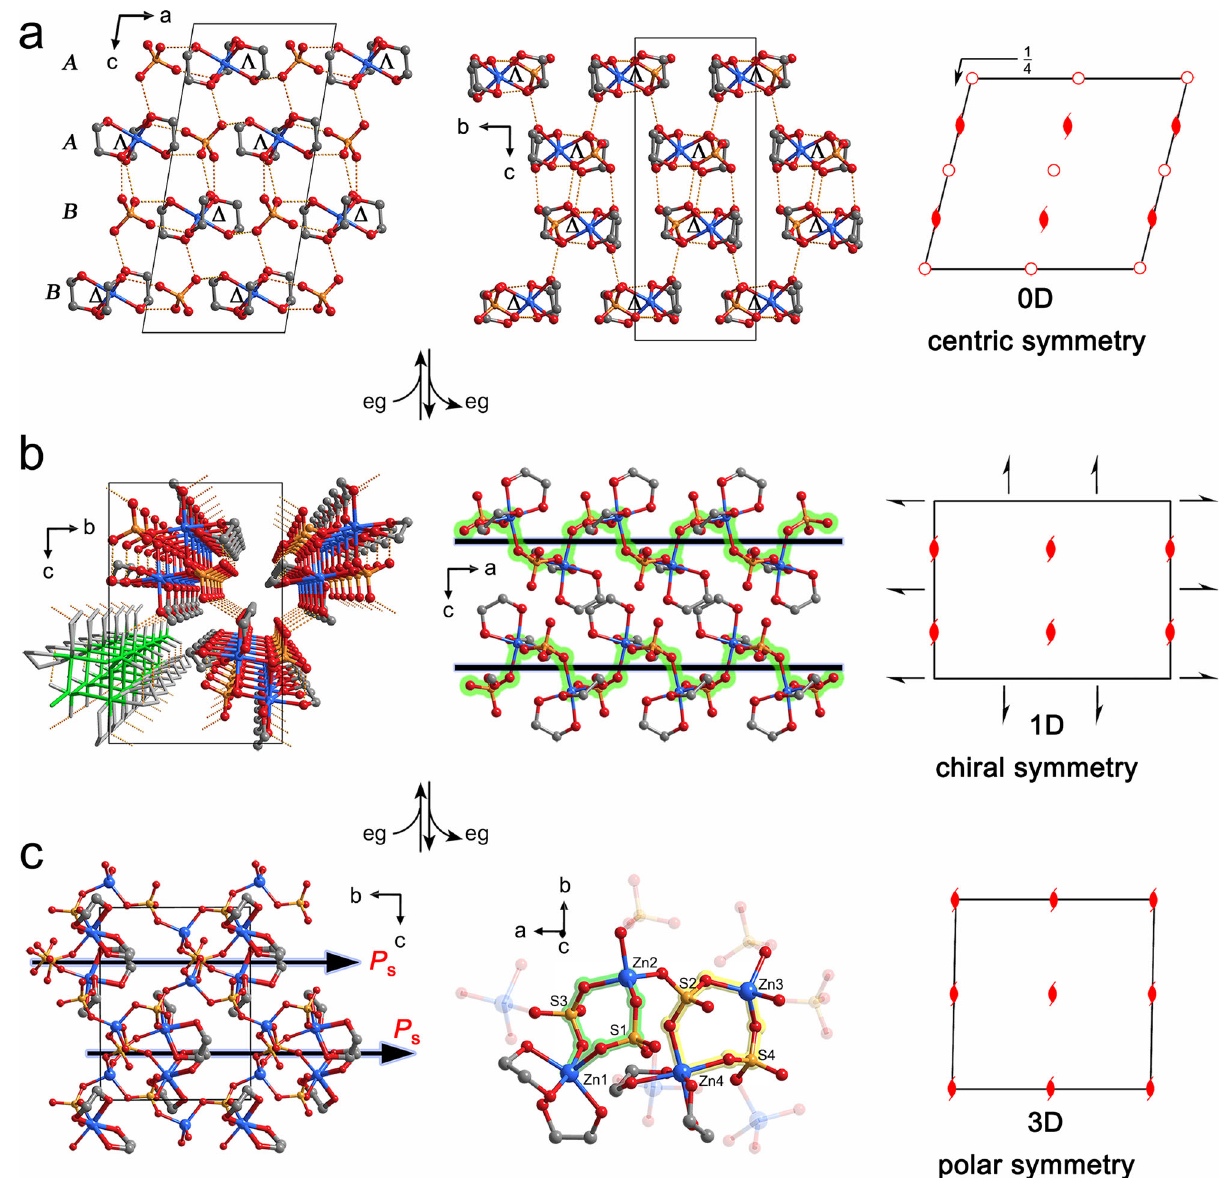
Fig. 1 Two-step reversible SCSC transformation associated with symmetry variation. a The single-crystal structure of 1-0D . In the crystal, the Zn II ions coordinated by three eg ligands in Λ or Δ con fi gurations manifest as discrete metal complexes that are connected by sulfate dianions through strong hydrogen bonds. The complex cations in Λ and Δ con fi gurations are arranged in AABB mode along the crystallographic c axis. b The single-crystal structure of 1-1D . One of the three eg ligands is replaced by two sulfate dianions during the fi rst-step SCSC transformation. Correspondingly, the Zn II ions are linked into 1D helical structures that extend along the crystallographic a axis. c The single-crystal structure of 1-3D . After further elimination of one- third of the eg ligands, the structure transforms into a 3D network with a spontaneous polarization emerging in the crystallographic b axis. The dashed lines denote the O – H···O hydrogen-bond interactions. Zn, blue; O, red; C, gray; S,